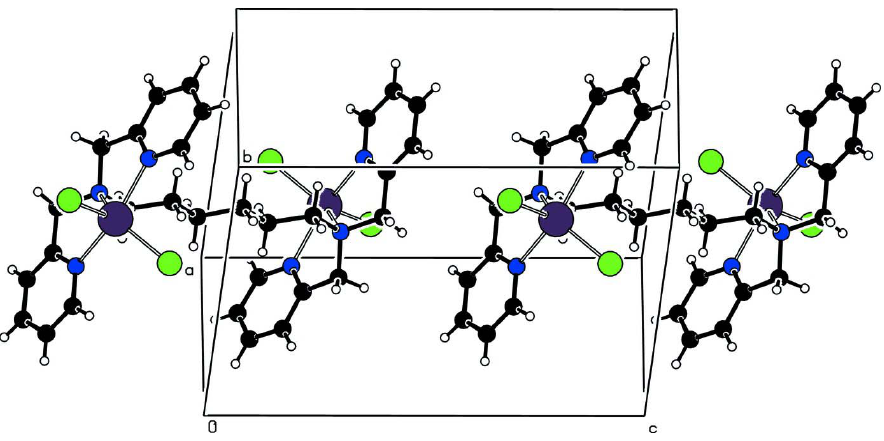
The structure of the title compound, with displacement ellipsoids drawn at the 50% probability level for non-H atoms